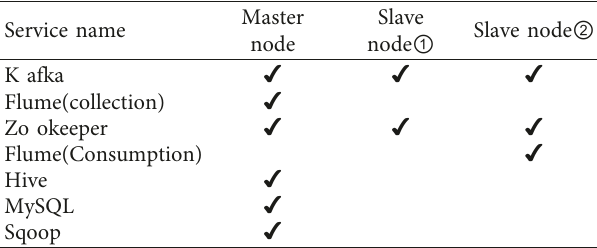
Table 2: Construction and testing of the gear cloud measurement system based on cloud